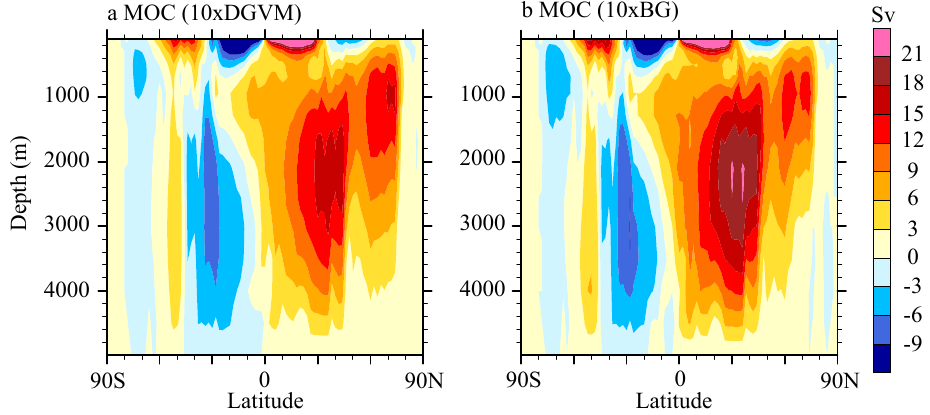
Fig. 8. Annual mean Meridional overturning circulation (Sv) for (a) 10xDGVM experiment; and (b) 10xBG experiment. Positive (in yellow and red) means clockwise flow direction and negative means counterclockwise flow